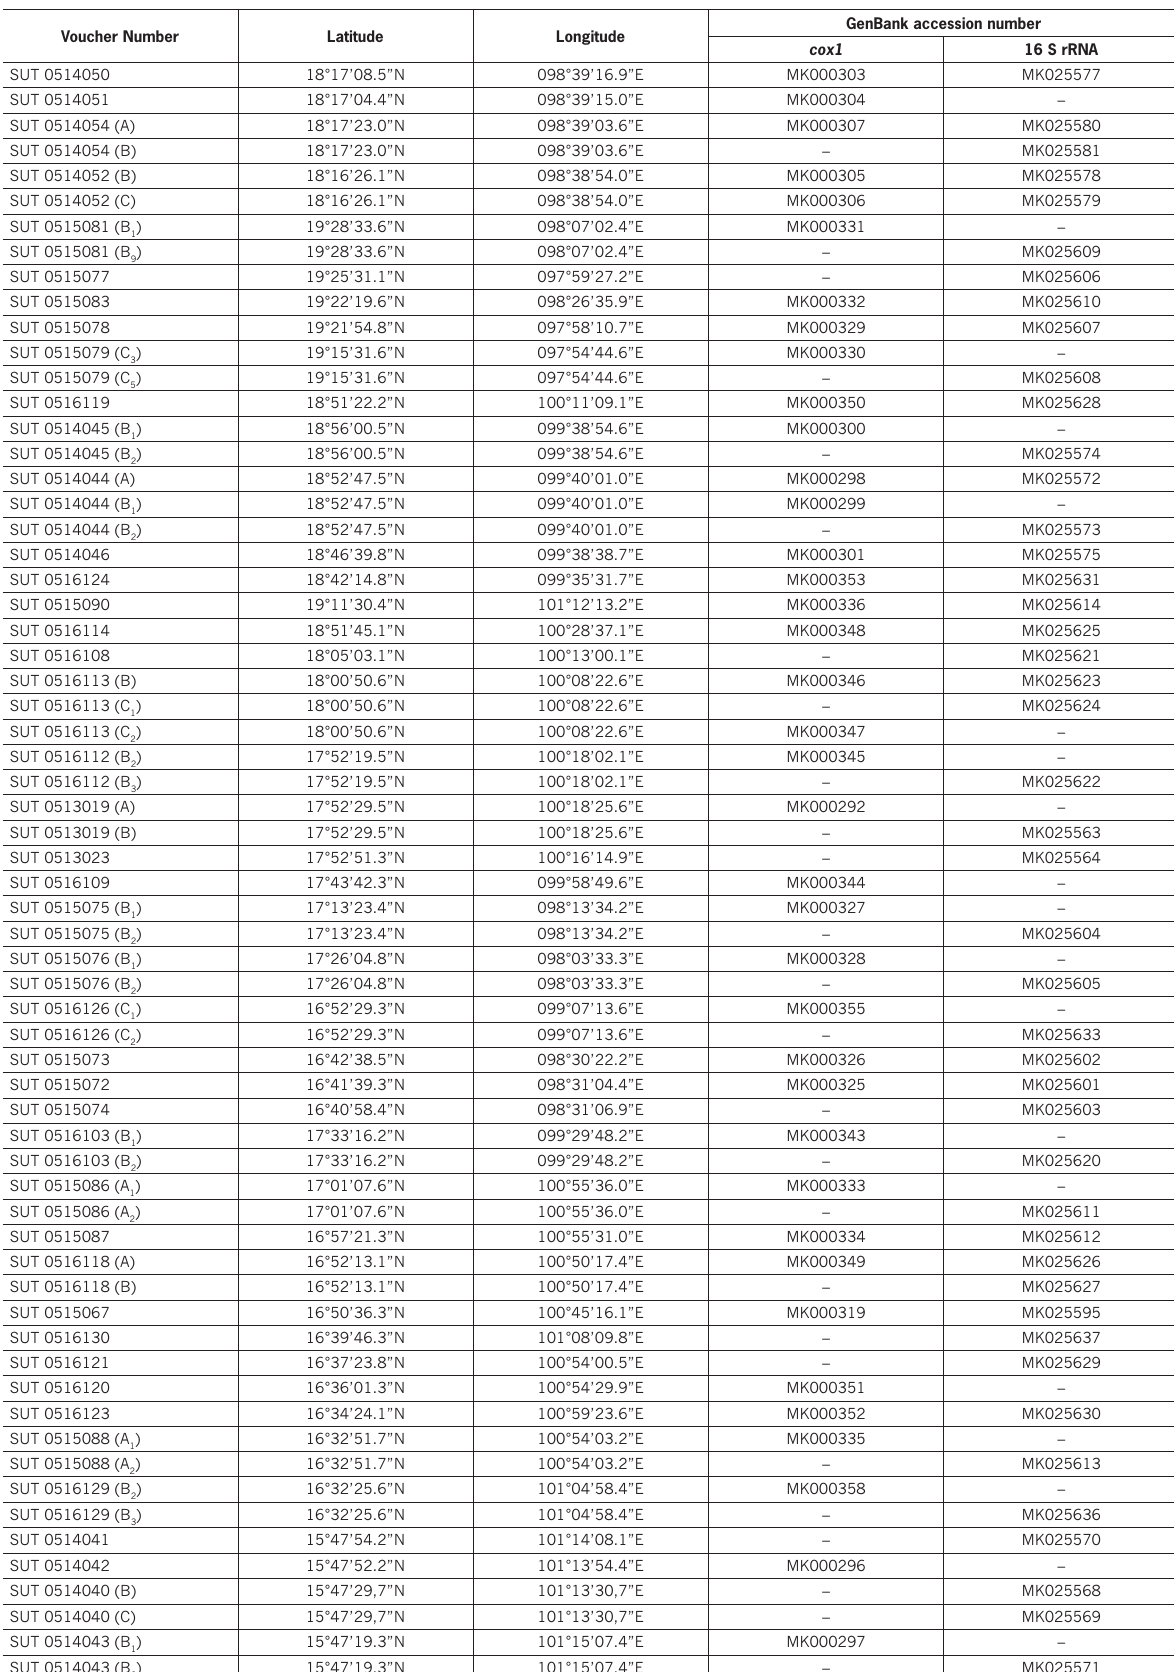
Table 1. Collection voucher numbers, geographic coordinates of sampling sites and GenBank accession numbers for specimens of Tarebia granifera (Lamarck, 1816) used in the molecular analyses. Voucher